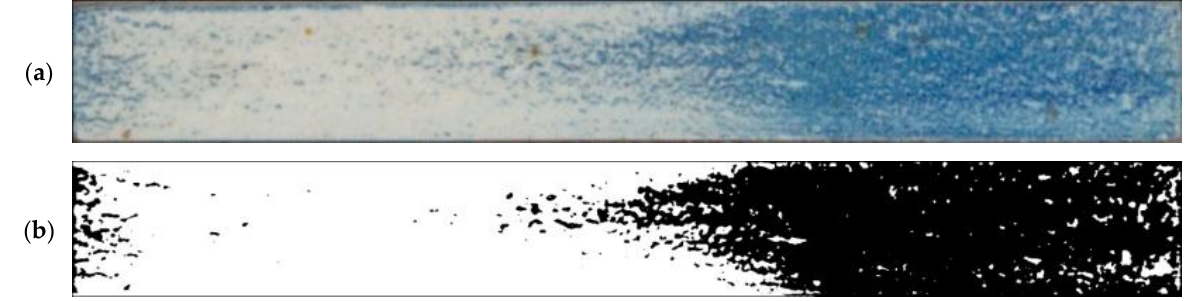
Figure 3. Scanned image of the finished surface of the parts; ( a ) the original, ( b ) processed in the program.